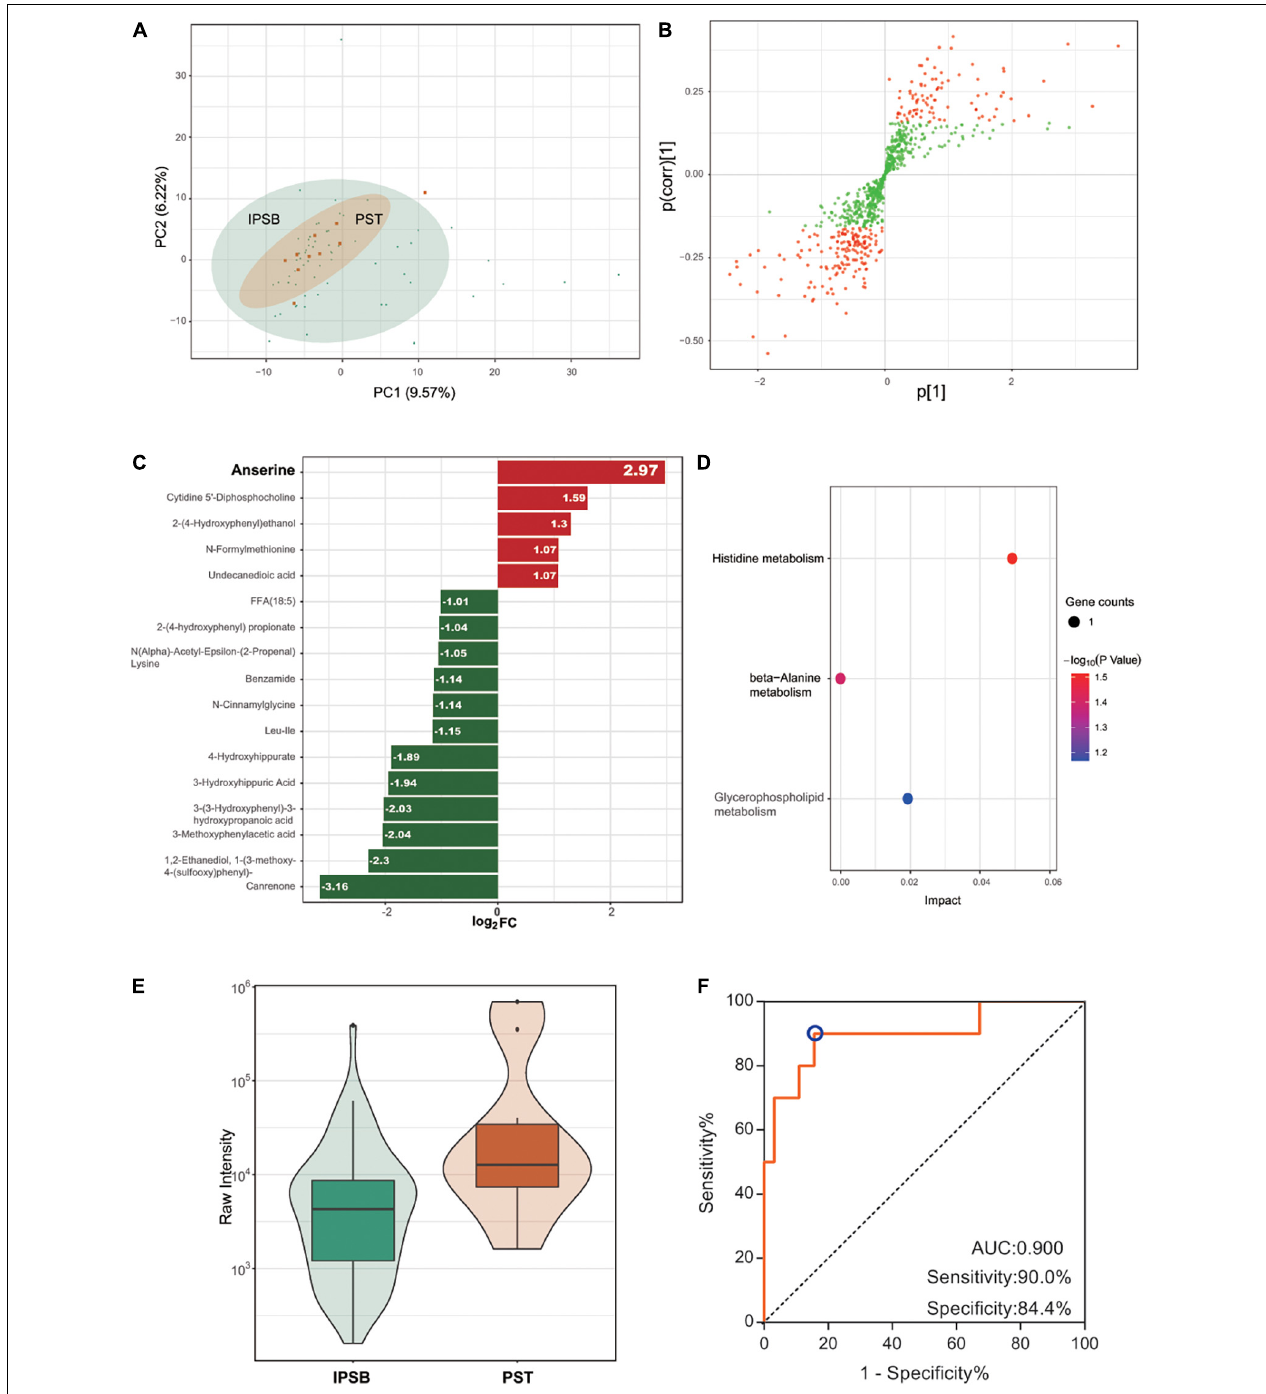
FIGURE 3 | Comparison between IPBS and PST. (A) The PCA plot between IPBS and PST. Each point in the graph represents a sample, the different colors of the points represent the grouping of the samples, the differences are not distinct in the plot. (B) OPLS-SPlot between IPBS and PST. VIP > 1, red plots represent different regulated metabolites. (C) The column chart shows different regulated metabolites between IPBS and PST. Red bars represent upregulated metabolites in PST, green bars represent downregulated metabolites in PST. Data are shown in log2 scale. (D) KEGG analysis of different regulated metabolites between IPBS and PST; histidine metabolism, beta-alanine metabolism, and glycerophospholipid metabolism were the main enriched pathways. (E) The violin diagram shows the most significantly upregulated metabolites. Anserine is the top upregulated metabolite in PST. (F) ROC curve of the prediction model to identify IPBS and PST. AUC is 0.9, sensitivity is 0.9, and specificity is 0.844; the blue circle represents the truncation value.